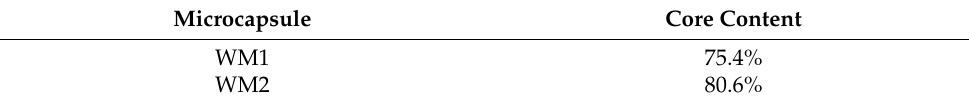
Table 5. Core content of microcapsules.